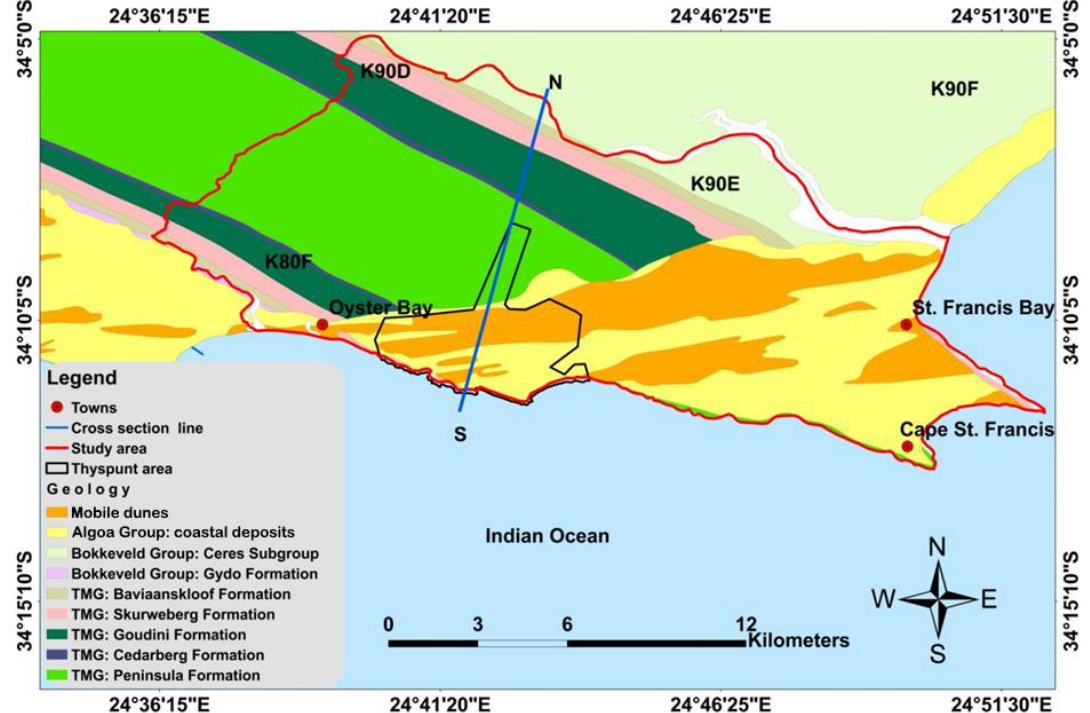
Figure 3. Geological map of Thyspunt area. Note N−S sectional line used for the conceptual model.